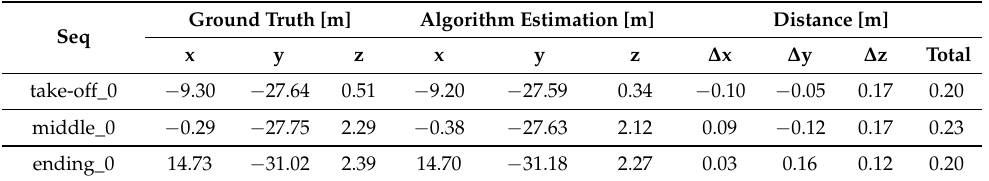
Table 3. Comparative table between the ground truth obtained by the total station and the output of the global location algorithm for the Algodonales viaduct.